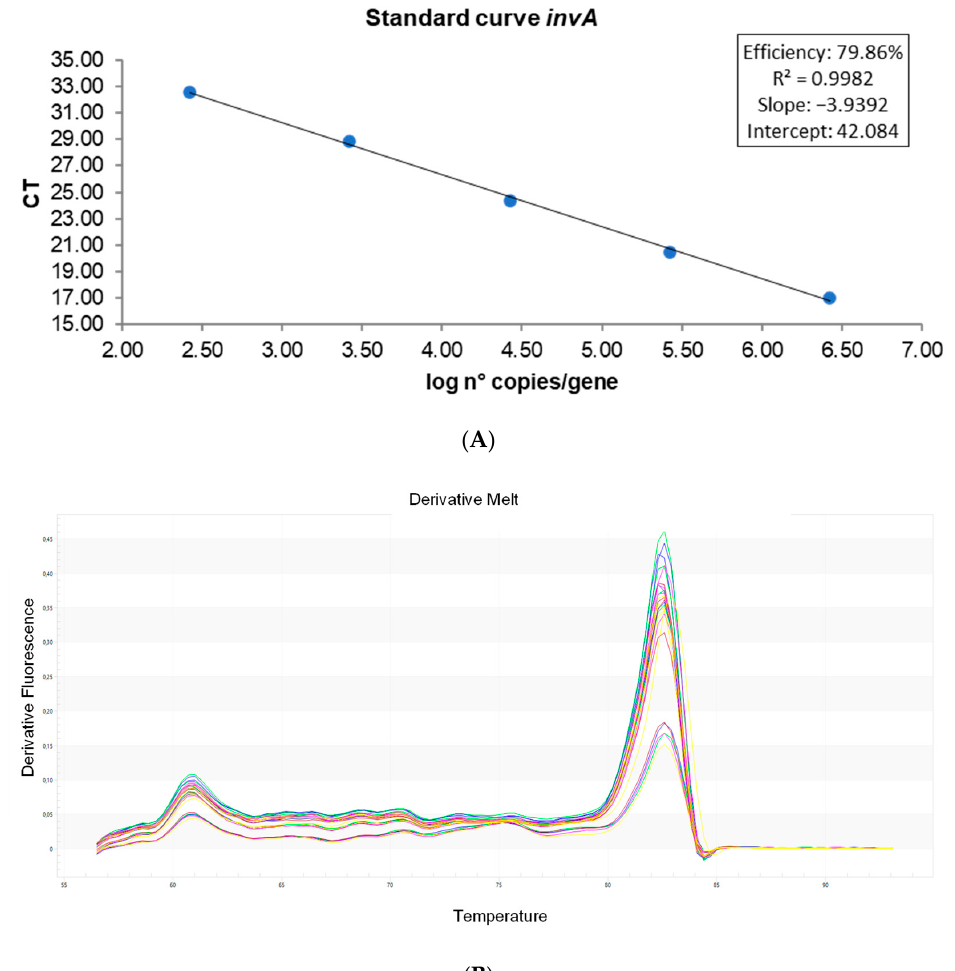
Figure 2. Amplification efficiency ( A ) and melting curve analysis ( B ) of primers targeting the invA gene. Ct values are averages from three measurements ( n =